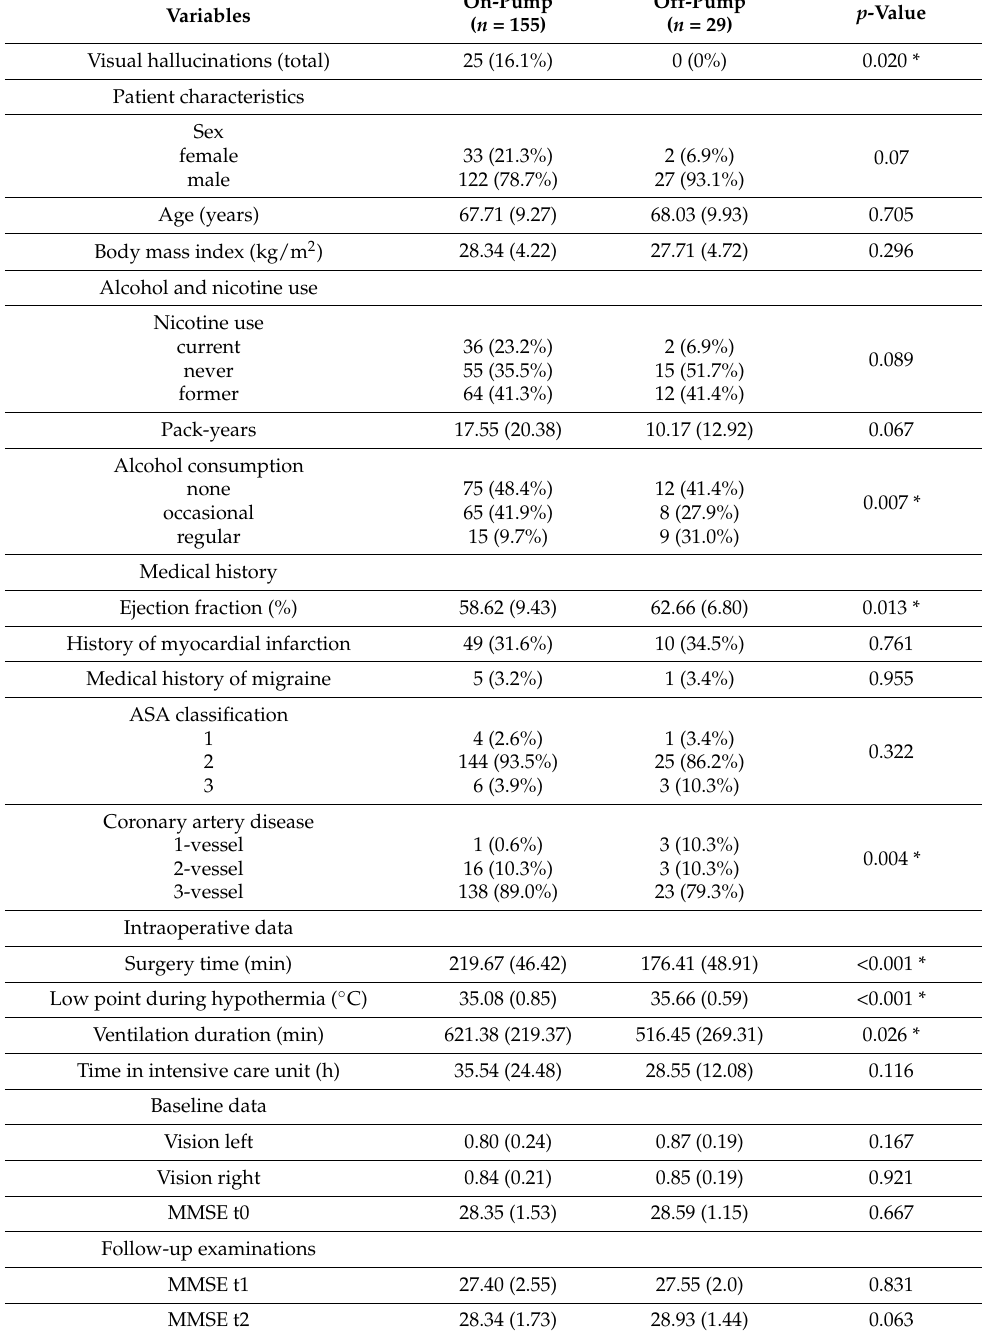
Table 1. Comparison of preoperative, intraoperative, and postoperative data of the on-pump vs. off-pump